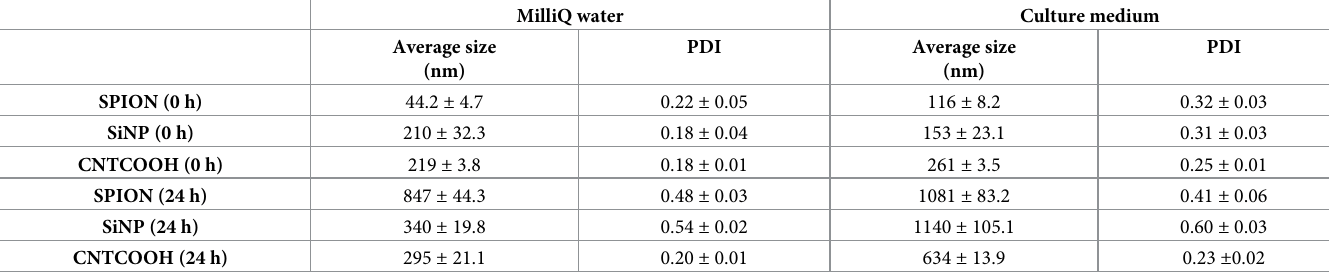
Table 2. Hydrodynamic diameters of the NPs obtained by dynamic light-scattering